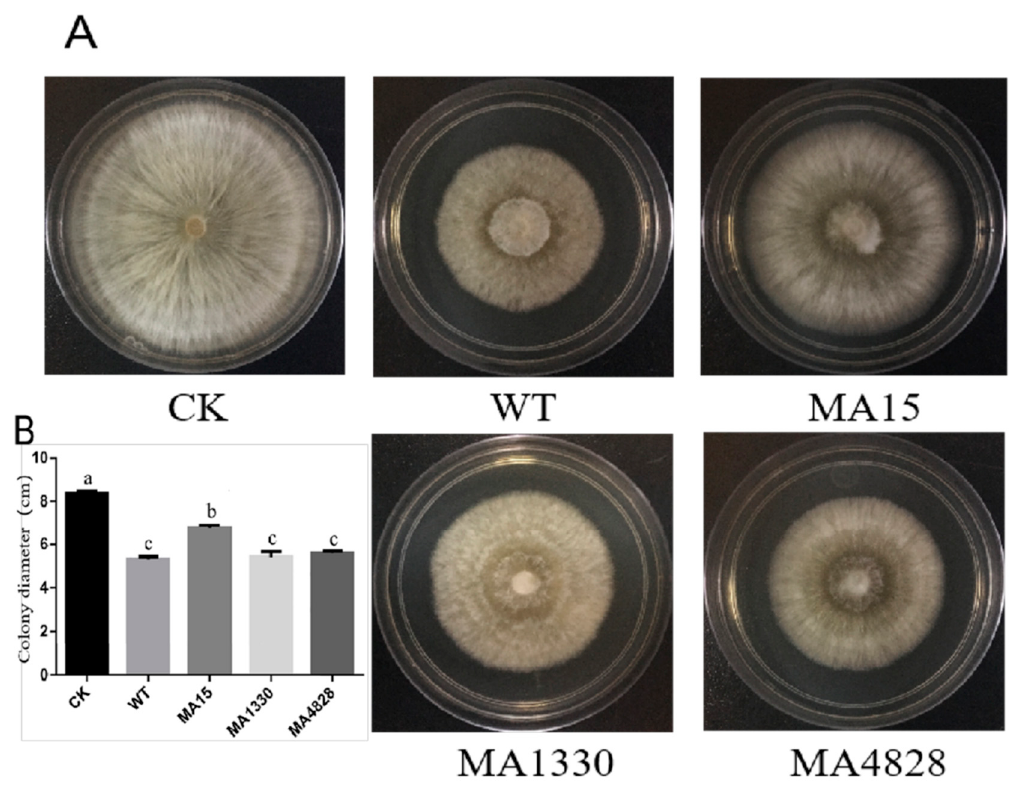
Figure 5. Inhibitory activity of fermentation liquid of WT B. pumilus HR10 and mutants against R. solani . The observation ( A ) and measurement ( B ) of the inhibition zones of fermentation liquid by 4 strains against R. solani . Error bars indicate the standard deviations from the results from three independent experiments. Different letters above the bars indicate significant differences ( p < 0.05).